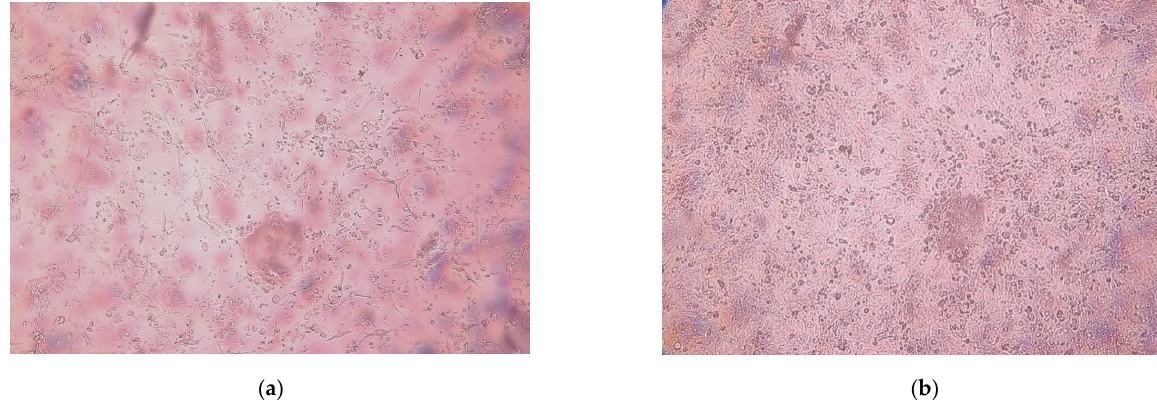
Figure 1. Cytopathogenic effects of TGEV on STE62 cell cultures ( a ) in comparison to the control culture ( b ) three days after inoculation. Inverted microscope Optika XDS-2 (Optika, Ponteranica, Italy), 100× magnification.